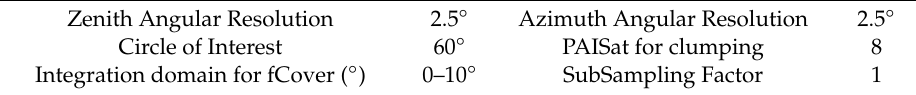
Table 1. General parameter inputs for CAN-EYE image processing. See the CAN-EYE user manual for detailed descriptions of each parameter